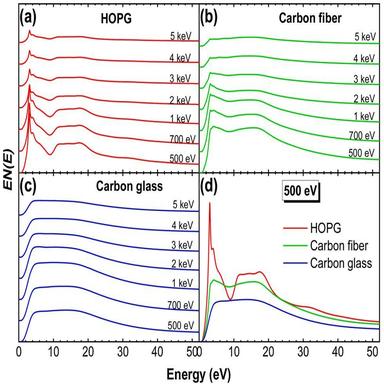
SES spectra at different primary energies of 500-5000 eV for (a) HOPG, (b) carbon fiber and (c) carbon glass. (d) Comparison on the energy spectra for the three materials at 500 eV.